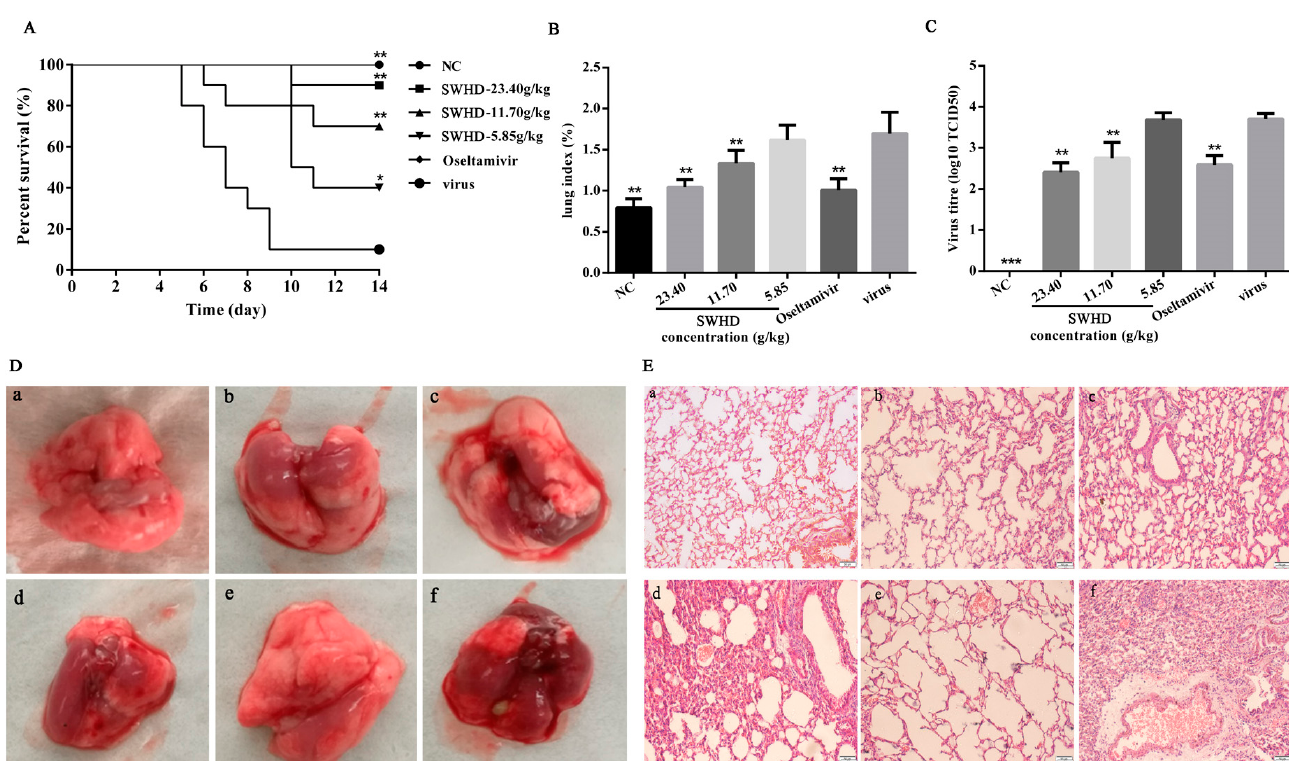
Figure 5. The in vivo protective activities of SWHD extract on lethal IFV infected mice. ( A ) Cum survival curve for indicated groups ( n = 10 per group). ( B ) Lung index for mice sacrificed at the fifth d.p.i. ( n = 10 per group). ( C ) Virus titre for mice at the fifth d.p.i. ( n = 10 per group). ( D ) Morphological changes in lung tissue from mice sacrificed at the fifth d.p.i. ( a ) mock infected mice treated with PBS (normal control, NC); ( b – d ) IFV-infected mice treated with 23.40,11.70 or 5.85 g/kg/day of SWHD extract; ( e ) IFV-infected mice treated with oseltamivir; ( f ) IFV-infected mice treated with PBS (viral control). Scale bar = 1 cm. ( E ) Histological observations of lung tissues for mice sacrificed at the fifth d.p.i. Scale bar = 50 μ m. ( a ) mock infected mice treated with PBS (normal control, NC); ( b – d ) IFV-infected mice treated with 23.40,11.70 or 5.85 g/kg/day of SWHD extract; ( e ) IFV-infected mice treated with oseltamivir; ( f ) IFV-infected mice treated with PBS (viral control). * p < 0.05; ** p < 0.01, when compared to the viral control.